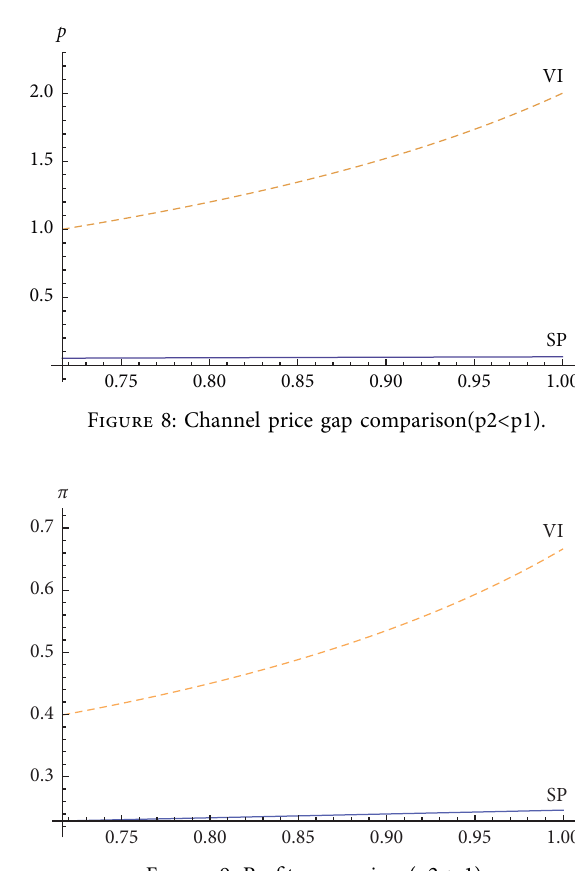
Figure 6: Proft comparison(p2 > p1).